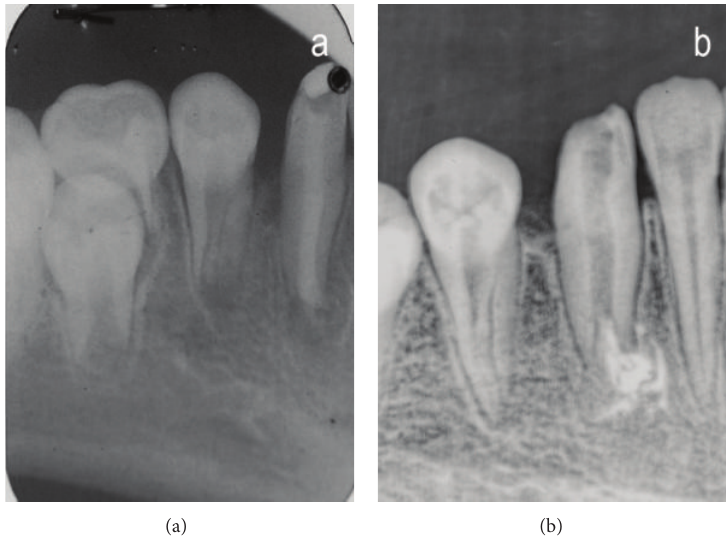
Figure 3: Lower periapical radiograph. (a) Monitoring phase (2007). (b) Treatment phase (May 2009).